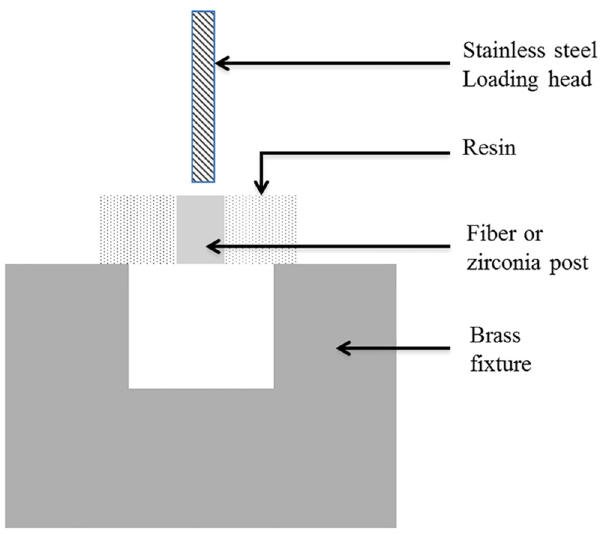
Fig 2. Schematic illustration of the push-out